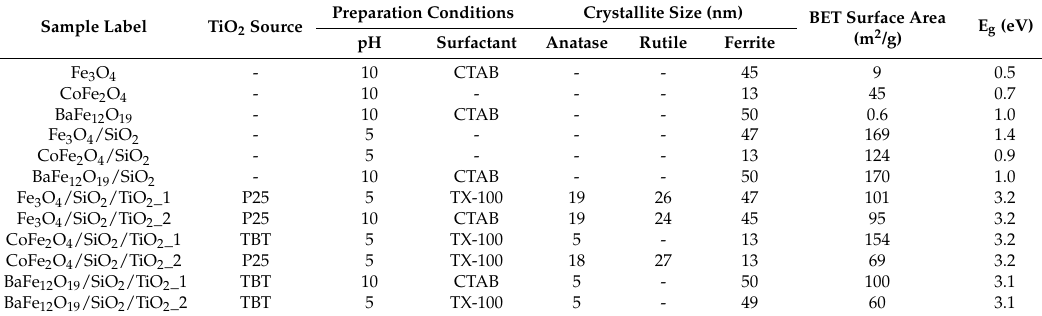
Table 1. Physicochemical characteristics of the ferrite particles and obtained magnetic